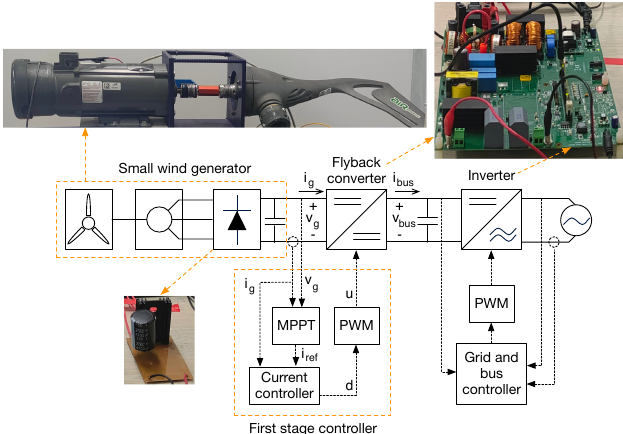
Figure 9. Experimental scheme of the small wind generation